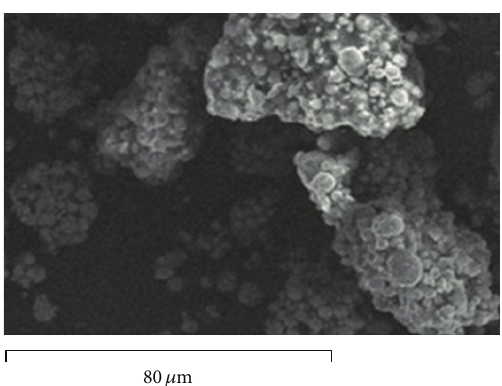
Figure 10: Scanning electron microscopy image with 750x magnifi-